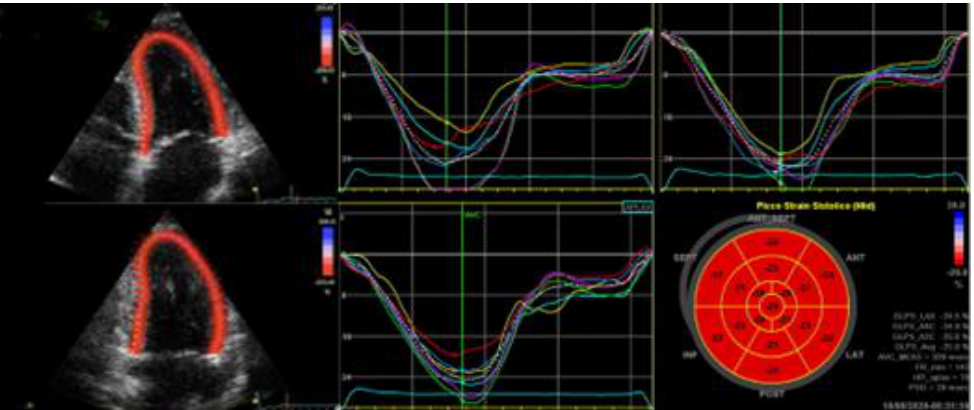
Figure 1. Two-dimensional speckle tracking: from recorded multiple heart beats during breath-hold, an apical four-chamber view, an apical two-chamber view, and an apical three-chamber view have been stored. Once the specific views have been named, it is required to trace the endocardial border in a still frame, setting the ROI. Finally, the evaluation of the deformation graphs and values may be calculated. The segmental peak systolic strains are represented in bullseye. ROI indicates region of interest.